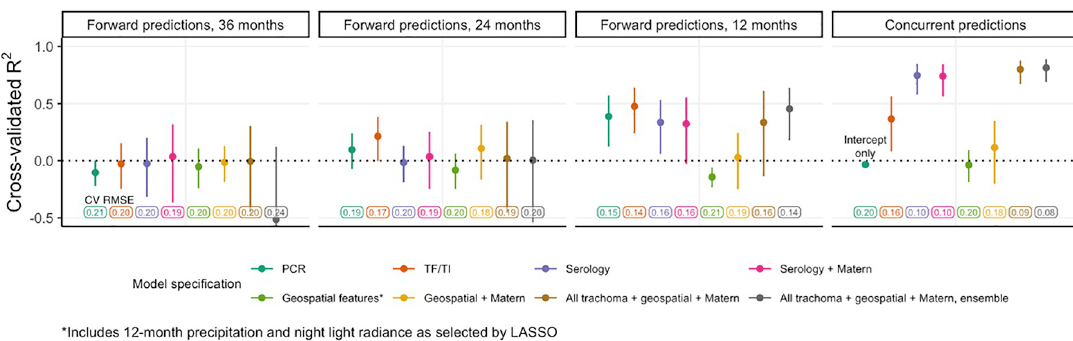
Fig 4. Cross-validated R 2 for models predicting month 36 community-level PCR prevalence among 0–5-year-olds. Cross-validated coefficient of determination (R 2 ), 95% influence-function-based confidence interval, and cross-validated root-mean-square error (RMSE, text label) are shown for each model specification. Logistic regression was used for all models with the exception of the stacked ensemble (gray). Blocks of size 15x15 km were used for 10-fold spatial cross-validation.